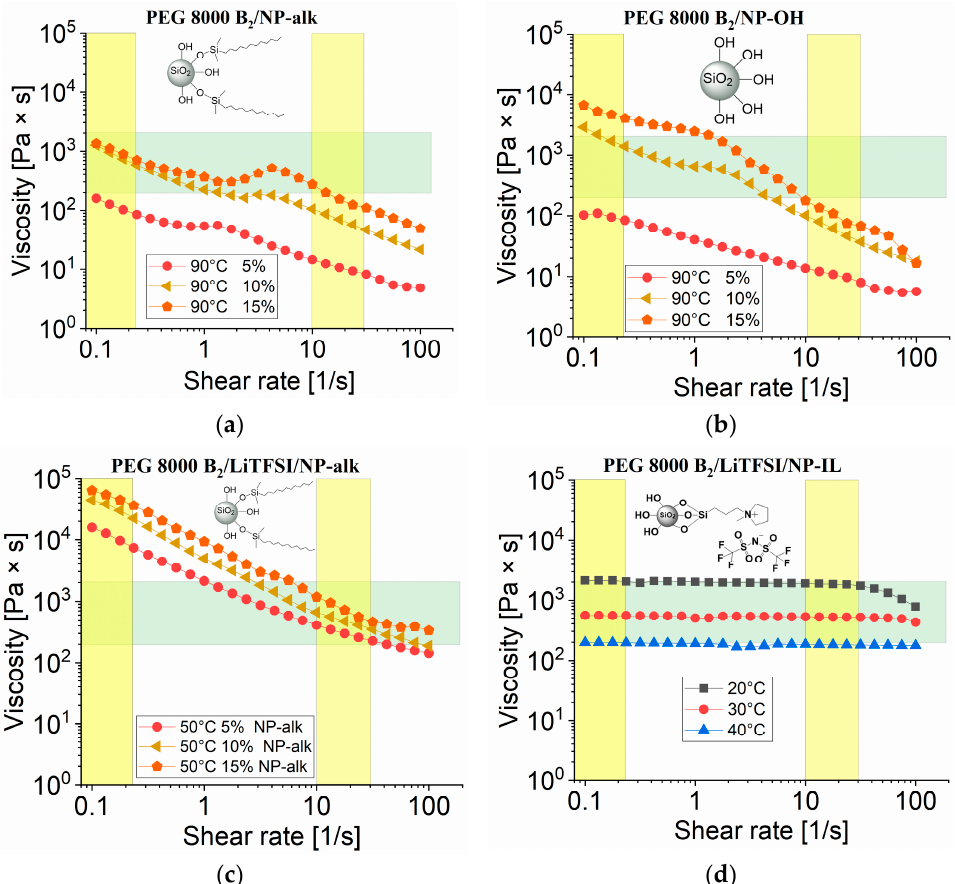
Figure 7. Rheology measurement of viscosity vs. shear rate for ( a ) PEG 8000 B 2 mixed with NP − alk (5% ( 15 ), 10% ( 16 ), 15% ( 17 )) at 90 °C; ( b ) PEG 8000 B 2 mixed with NP − OH (5% ( 18 ), 10% ( 19 ), 15% ( 20 )) at 90 °C; ( c ) PEG 8000 B 2 mixed with LiTFSI (5:1) and NP − alk (5% ( 11 ), 10% ( 12 ), 15% ( 13 )); ( d ) PEG 8000 B 2 mixed with NP − IL (5% ( 14 )).